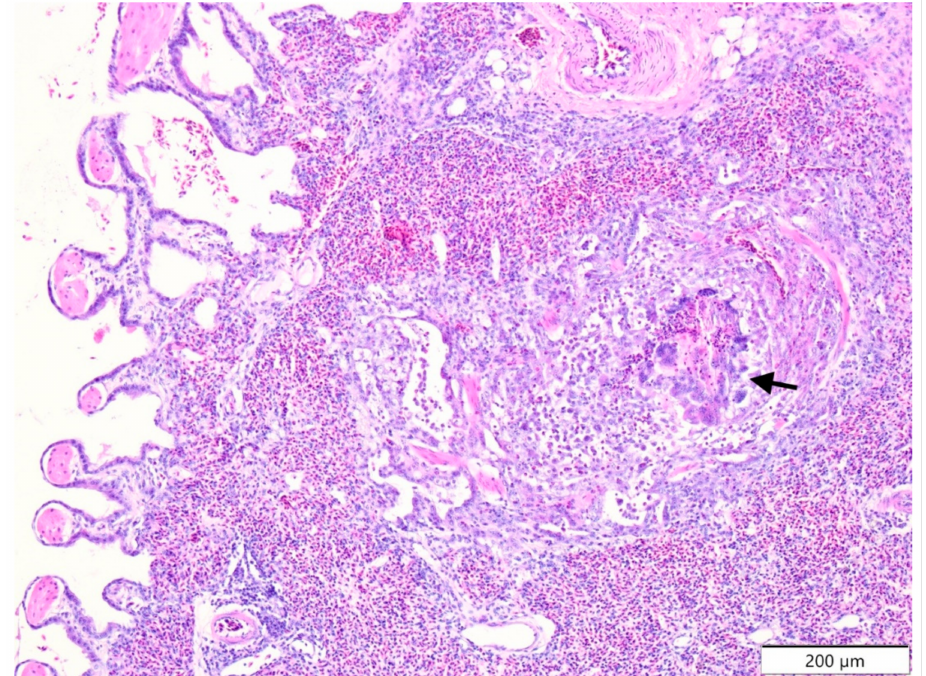
Figure 4. Japanese quail. Lung. CP group. 9th day of experiment. Granulomatous inflammation (black arrow). Congestion of the lung. Haematoxylin and eosin